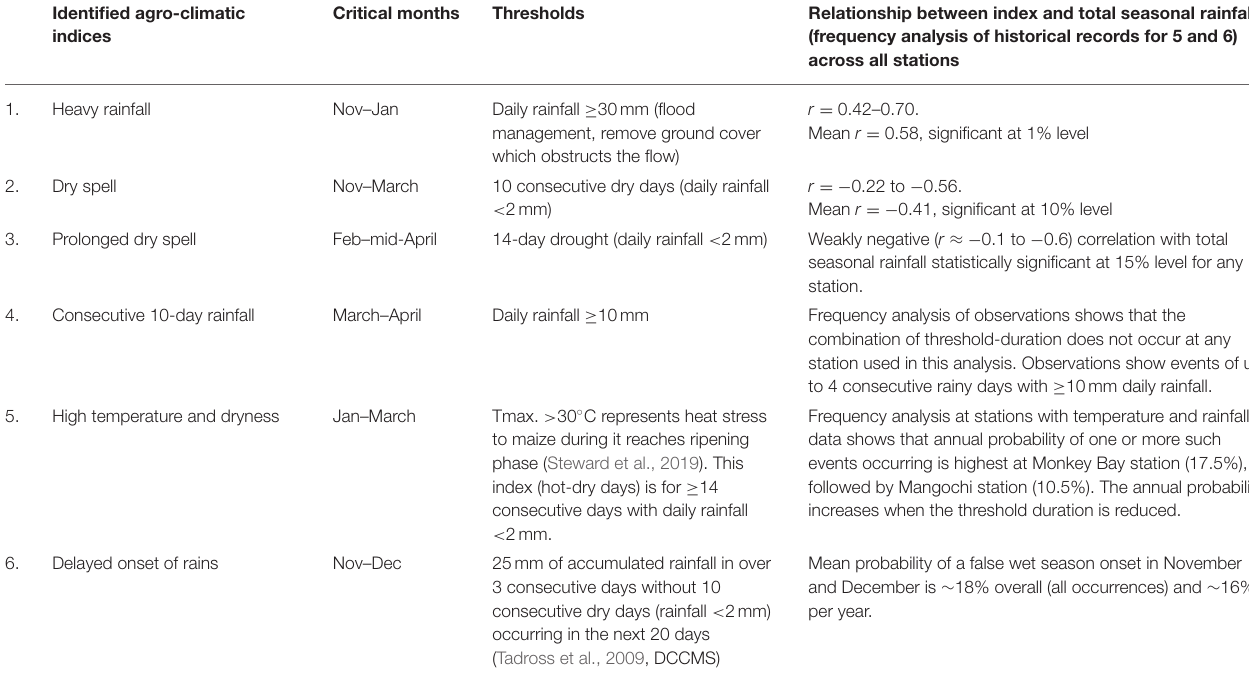
TABLE 2 | Details of identified maize specific agro-climatic indices, and corresponding critical months, thresholds, empirical relationship with total wet season rainfall. Identified agro-climatic